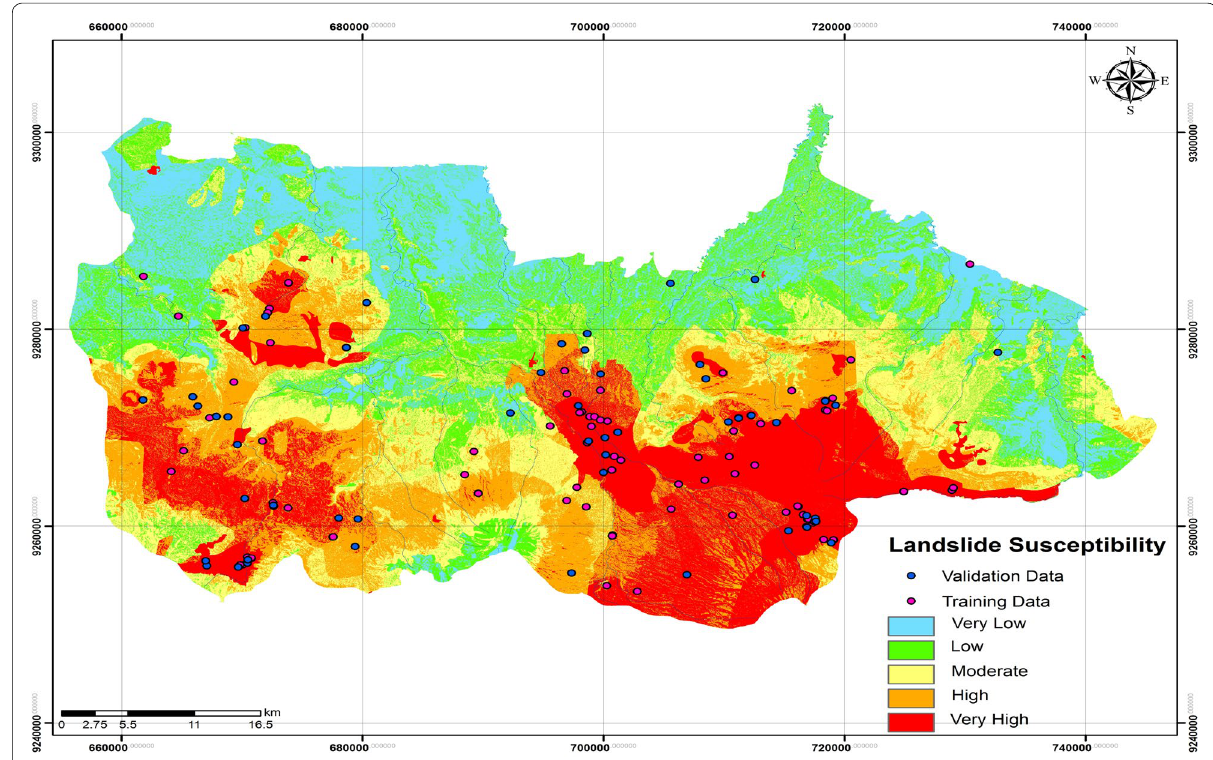
Fig. 12 Landslide susceptibility map based on the FR